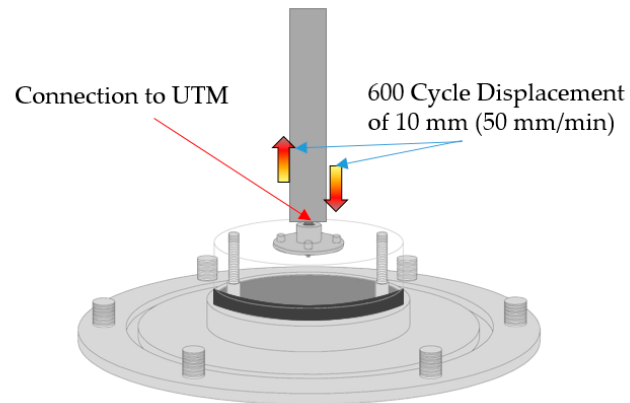
Figure 11. Illustration of substrate movement resistance testing.